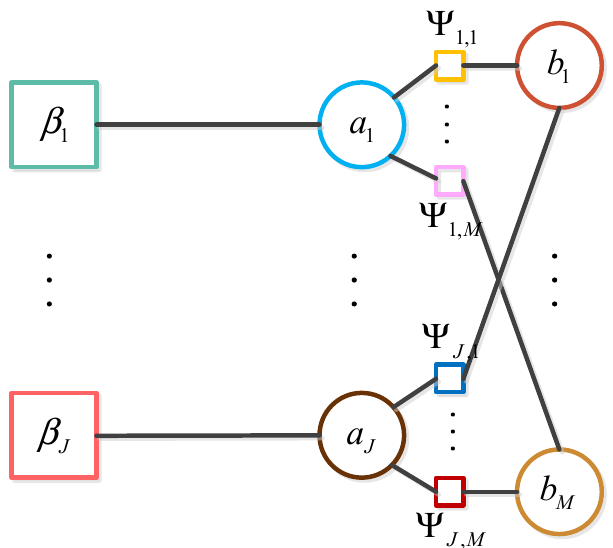
Figure 2. Factor graph of (46) and (47).